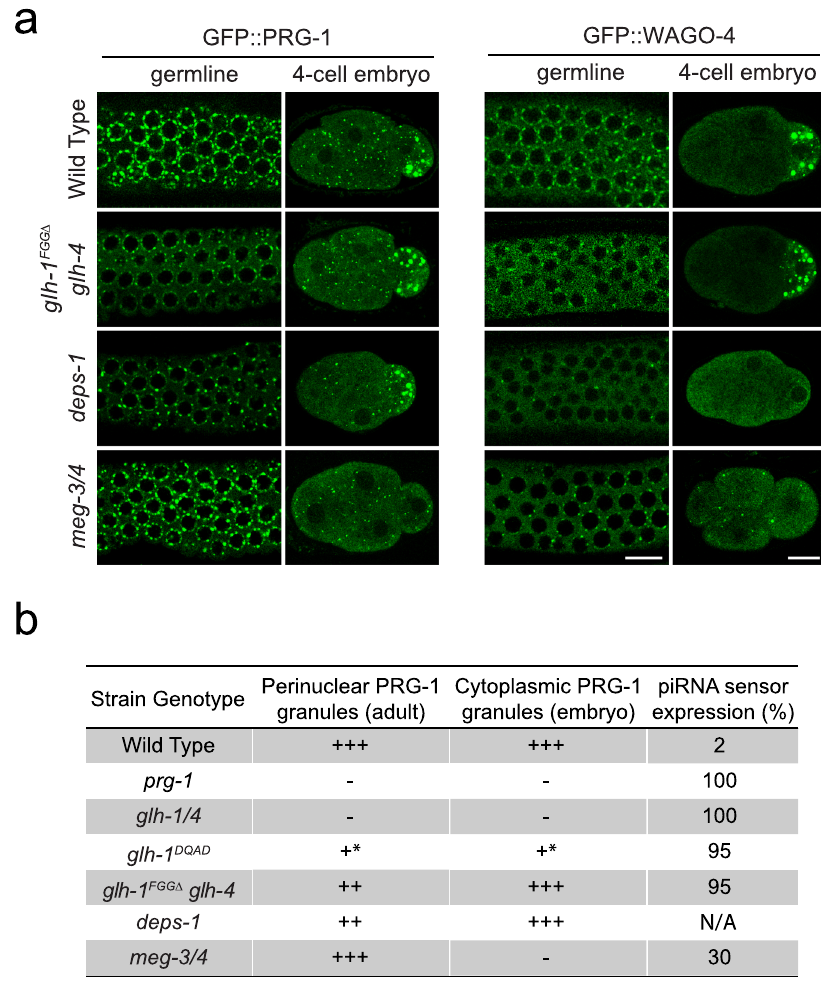
Fig. 3 | Mutants with defective in either perinuclear or cytoplasmic P granules exhibitdefectsingenesilencing.a Fluorescentmicrographsshowthelocalization of PRG-1and WAGO-4inthe indicated strainsinthe adult germline (left)and inthe four-cell embryo (right). Bar, 10 micrometers. Quanti fi cation of each genotype ’ s